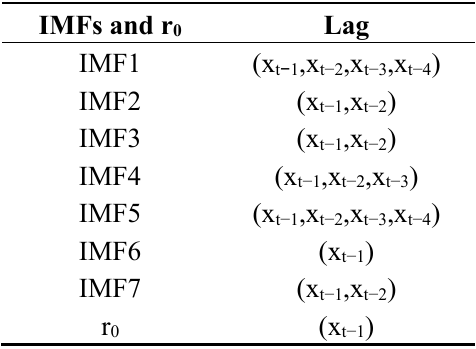
Table 4. Result analysis of PACFs of IMFs and r 0 of the wind speed after FEEMD.